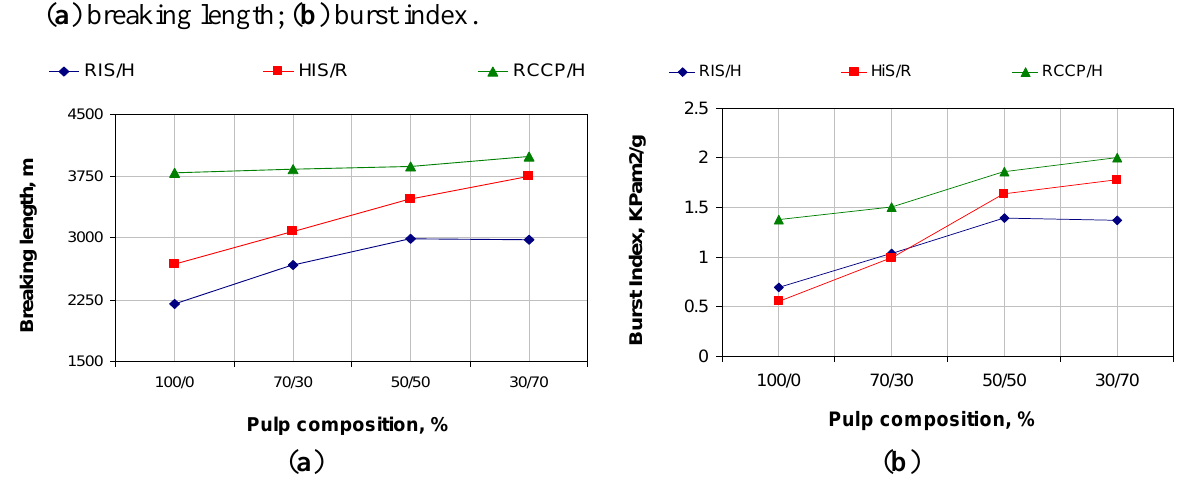
Figure 10. Evolution of mechanical properties in relation with pulp